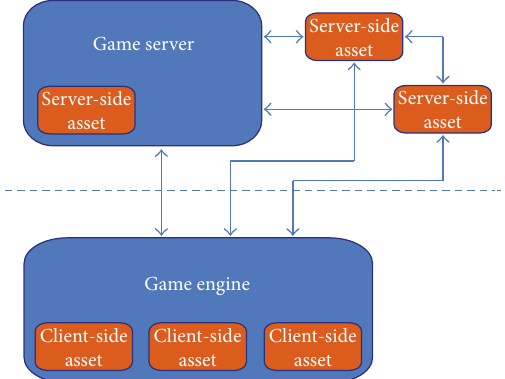
Figure 2: Distributed architecture of client-side assets and server- side assets supporting a